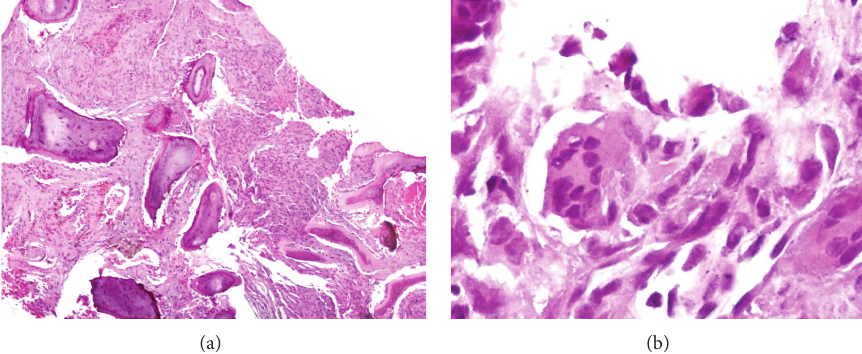
Figure 2: (a) Bone lesion composed of multiple multinucleated giant cells mixed with stromal spindle cells with hemosiderin deposition. H&E stain, × 50. (b) Multinucleated giant cell surrounded by stromal spindle cells. H&E stain, × 400.